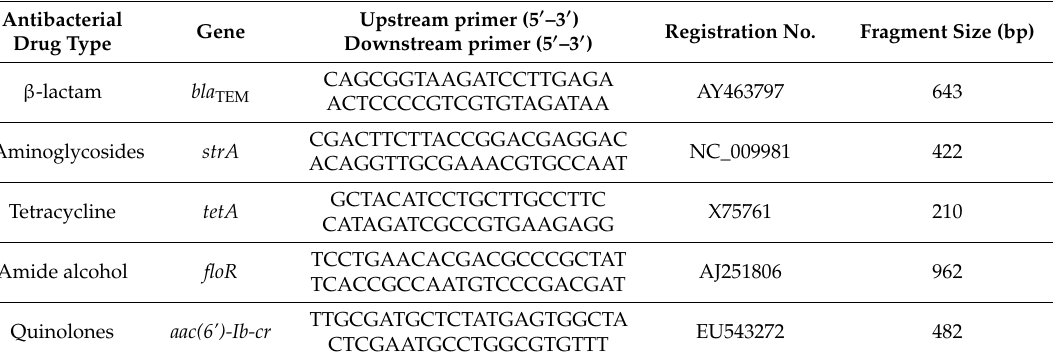
Table 1. Primer sequences of resistance genes.